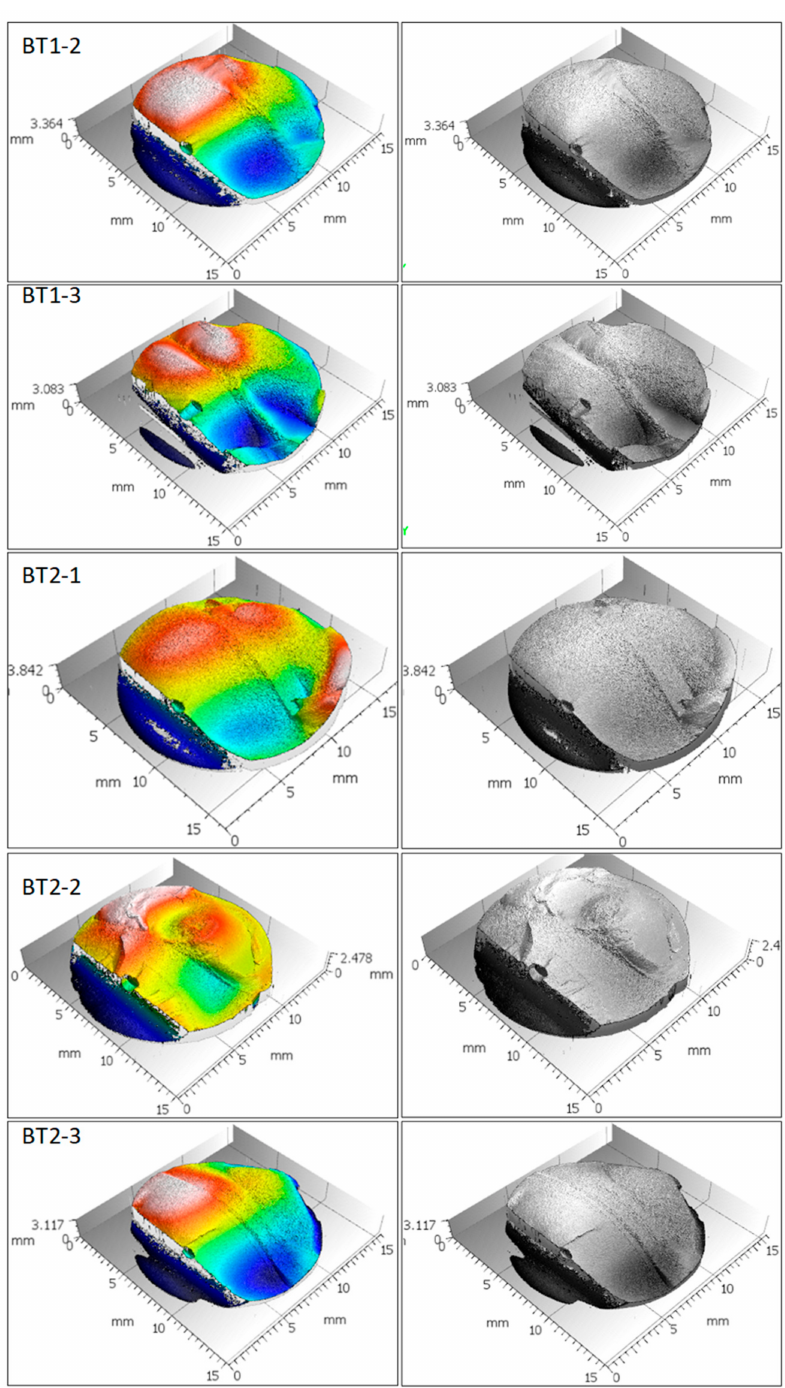
Figure A1. Original measured surfaces of